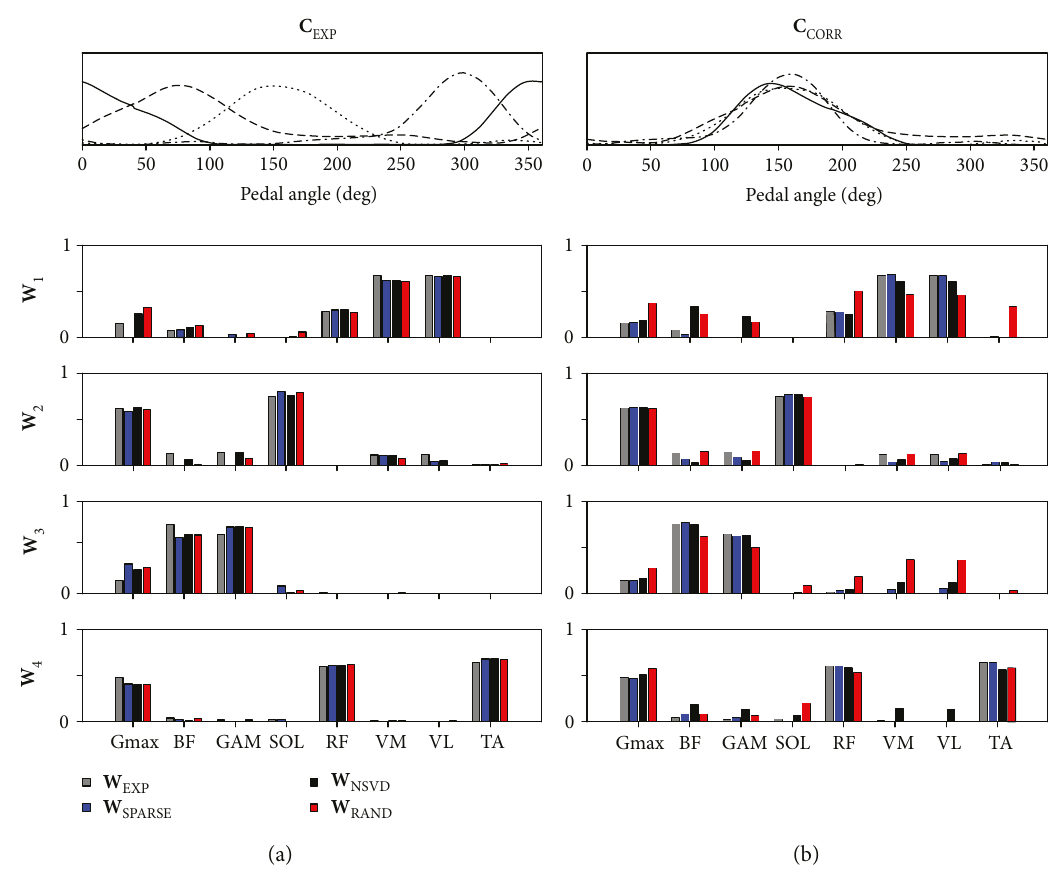
∗ C EXP EXP ; synergy (upper) and synergy vectors CORR